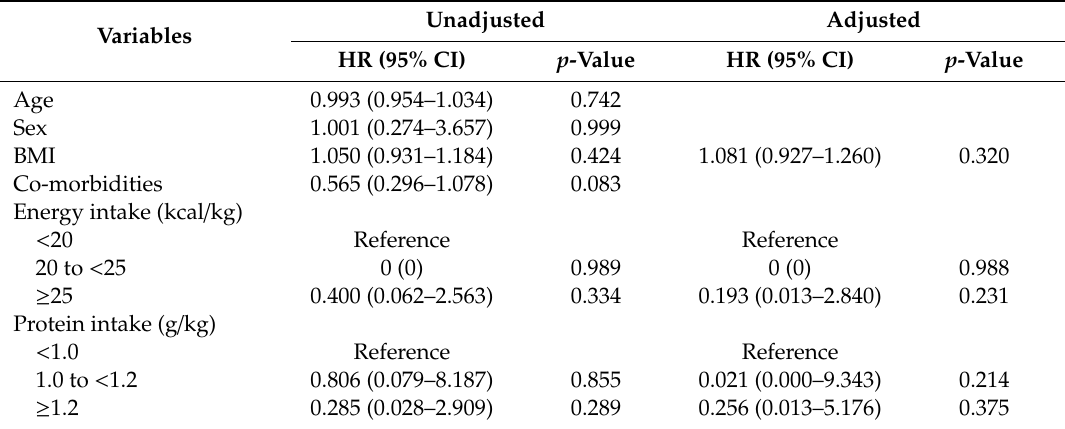
Table 4. Cox regression analysis for 28-day mortality in low nutritional risk group.